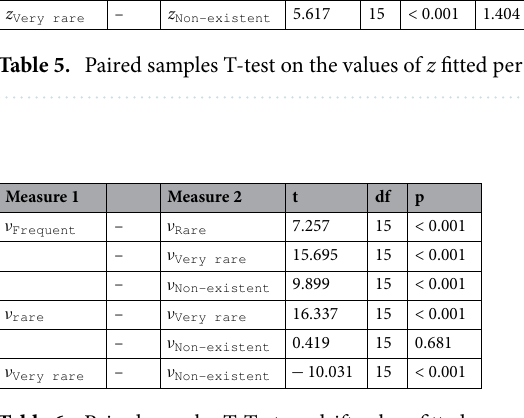
Table 6. Paired samples T-Test on drift values fitted per word type on the lexical classification dataset.